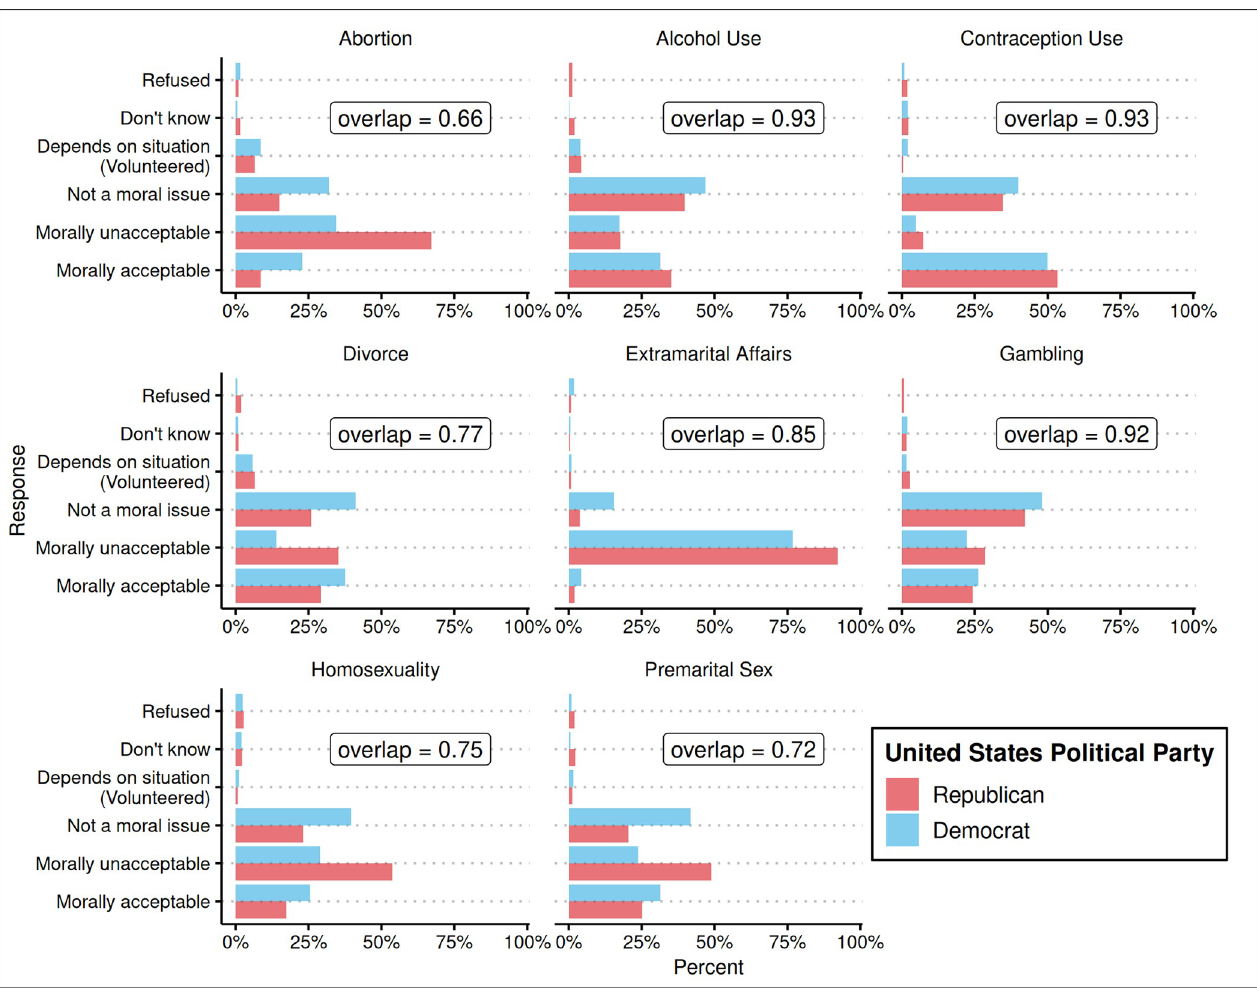
Fig 2. Democrat-Republican overlap for moral issues.